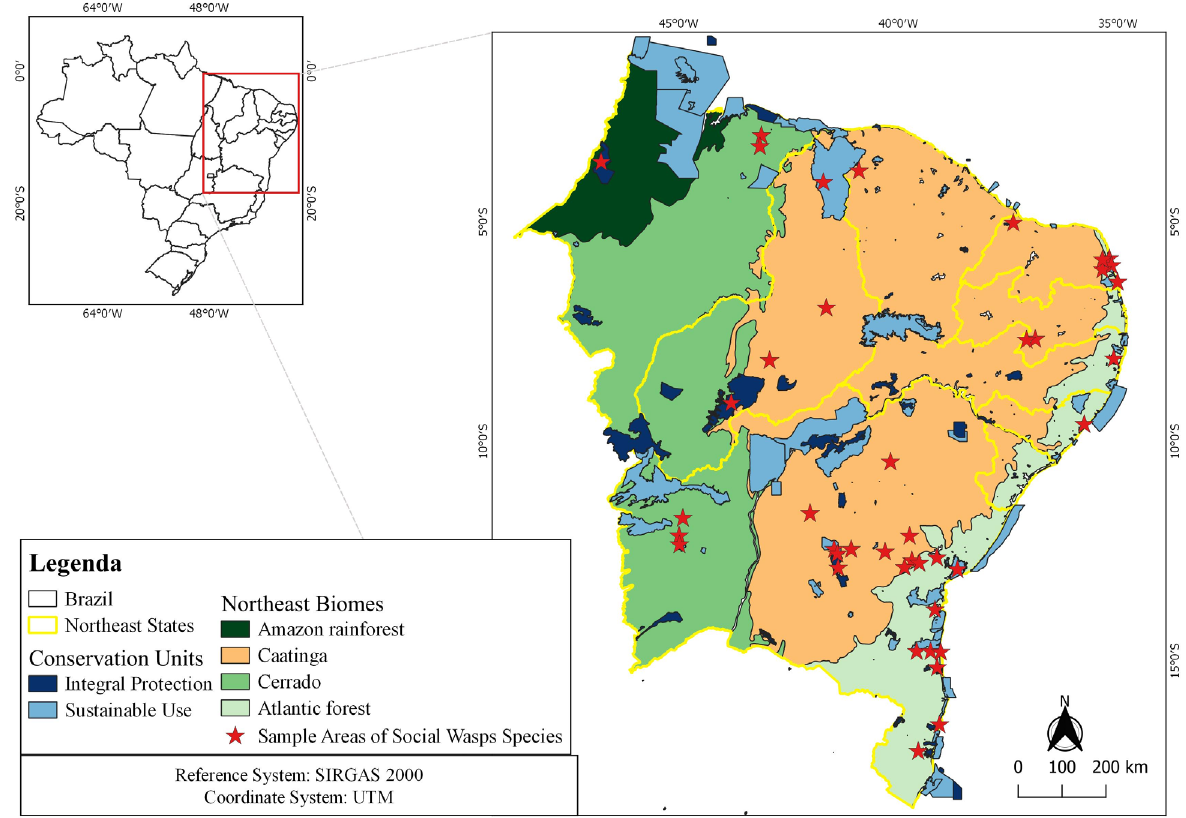
Fig 2. Areas chosen for sampling social wasps in the Northeast Region of